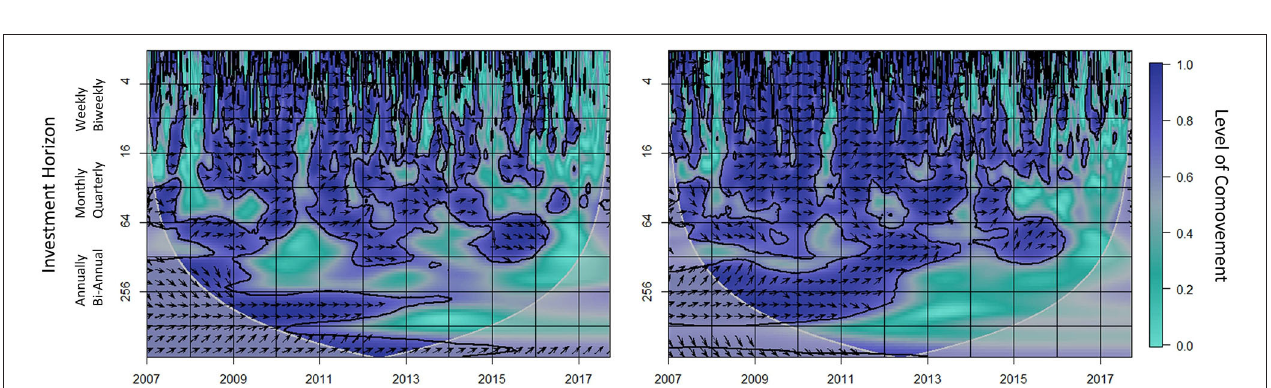
FIGURE 6 | The WSC of the water-energy nexus (left) and energy and S&P500 (right) . The vertical axis shows investment horizons in days and the horizontal axis shows time in years. The darker purple the regions are the higher the statistical significant level of comovement. The regions that are lined with black are regions of statistical significance at the 5% level estimated using Monte Carlo simulations. The white overlay defines the cone of influence. The arrows are an indication of phase movement (leading-lagging relationship) described in section 2.2.3.